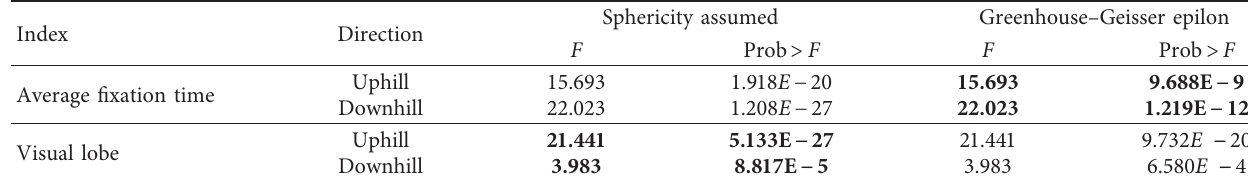
Table 5: Tests of within-subject effects (one-way repeated measures